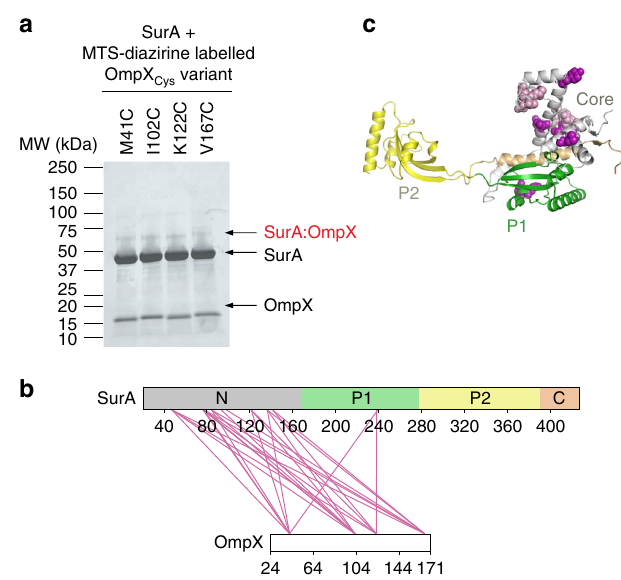
Fig. 5 Multiple locations across the OmpX sequence interact with similar sites on SurA. a Tag-transfer photo-cross-linking 48 of SurA-OmpX complexes using OmpX Cys variants labelled with MTS-diazirine analysed by SDS-PAGE. A band corresponding to the SurA-OmpX complex is observed for all OmpX variants following UV irradiation. These bands were not observed when analysed using reducing SDS-PAGE (Supplementary Fig. 8b). Source data are provided as a Source Data fi le. b Inter-molecular cross-links detected in the SurA-OmpX complex (Supplementary Table 8). c Structure of SurA with residues which were photo-cross-linked to labelled OmpX Cys variants shown in purple. Where the data quality did not permit residue level assignment, the cross-linked peptide is shown in light purple. Samples contained 10 μ M SurA, 5 µ M MTS-diazirine-labelled OmpX, 0.24 M urea, in 10 mM potassium phosphate buffer, pH 8.0, 25 °C and cross-linking was initiated by UV LED irradiation of the sample for 30 s (see Methods). A representative mass spectrum for each cross-link can be found in Supplementary Data